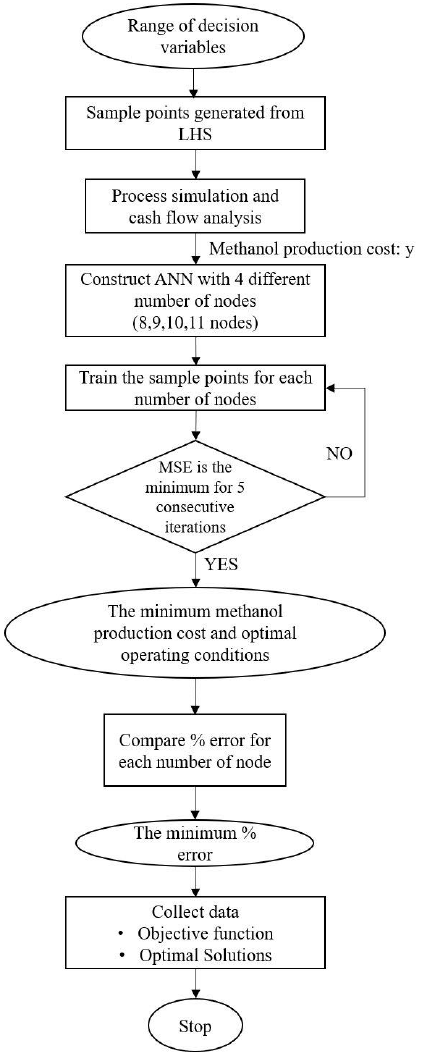
Figure 2 . Algorithm for Latin hypercube design for artificial neural network training . Figure 2. Algorithm for Latin hypercube design for artificial neural network